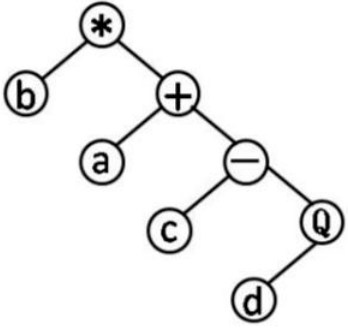
Figure 1. Expression trees.